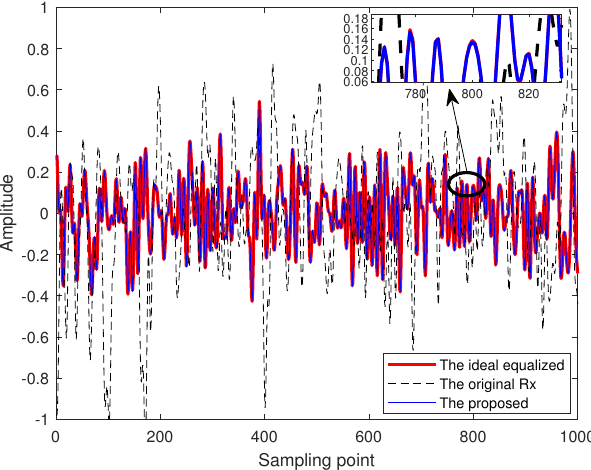
Figure 6. Amplitude comparison of the proposed scheme with the ideal